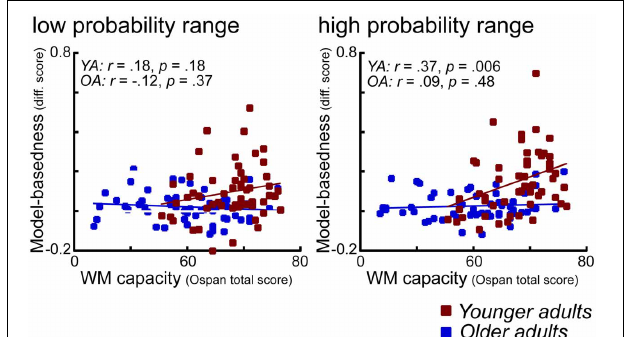
FIGURE 6 | Scatter plots for the correlations between model-based difference values (see Methods) and WM capacity (OSPAN total scores), displayed separately for the low and the high reward probability range conditions. Younger adults are shown in red, older adults are shown in